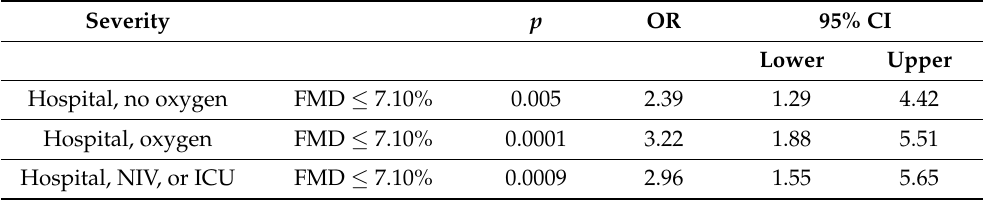
Table 5. Multinomial regression analysis (reference category: not